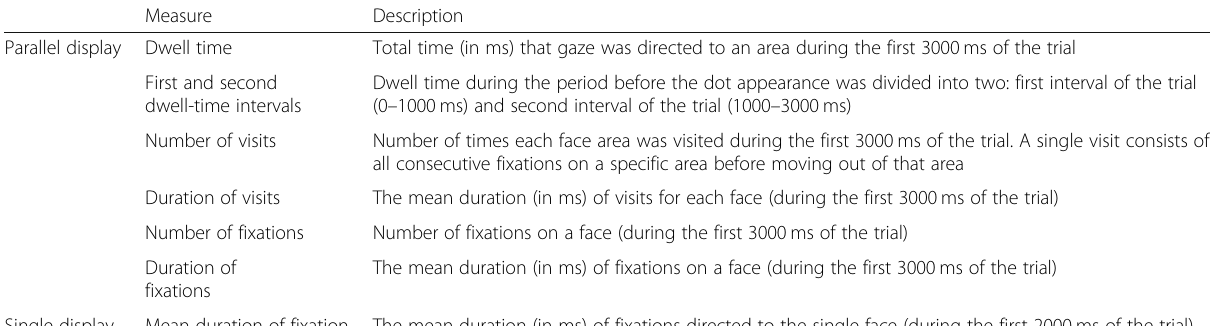
Table 1 Definition of the different ocular measures used in the statistical analysis Measure